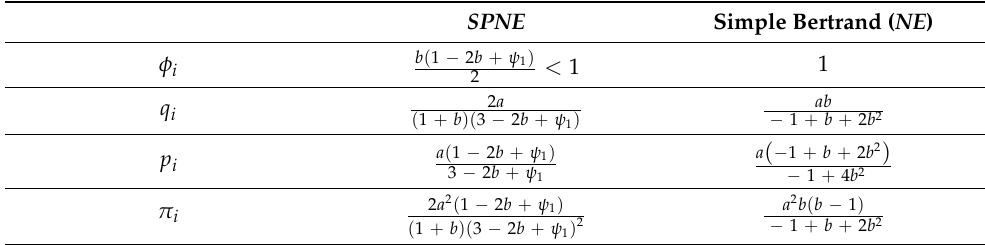
Table 2. Equilibrium values when firms compete in price.